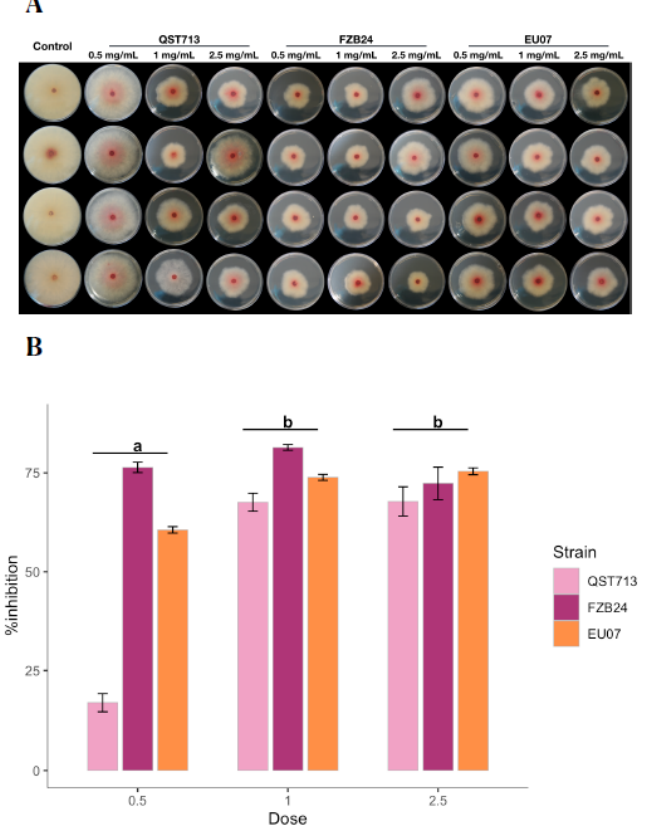
Figure 4. Effect of different bacterial broth concentrations on Fg -K1-4 growth. ( A ) Antagonism assays using filtered, adjusted and autoclaved broths. Bacterial broths were obtained from 24 h bacterial cultures, filtered, adjusted and autoclaved. Protein concentrations in bacterial broths were adjusted to 0.5, 1.0 and 2.5 mg/mL in the PDA/NA media. ( B ) Percentage inhibition of Fg -K1-4 by the Bacillus broths, which were filtered and adjusted to 0.5, 1.0 and 2.5 mg/mL of total protein in medium. Data were from one independent experiment of eight repeats and shown as the mean ± SE. Experiments were replicated twice, and the similar results were obtained. Bars clusters with different letters were significantly different according to Tukey’s Test (α < 0.05) following two-way ANOVA. n = 96.